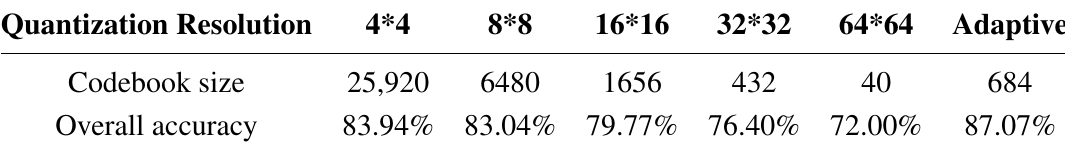
Table 4. The classification accuracy for the different quantization